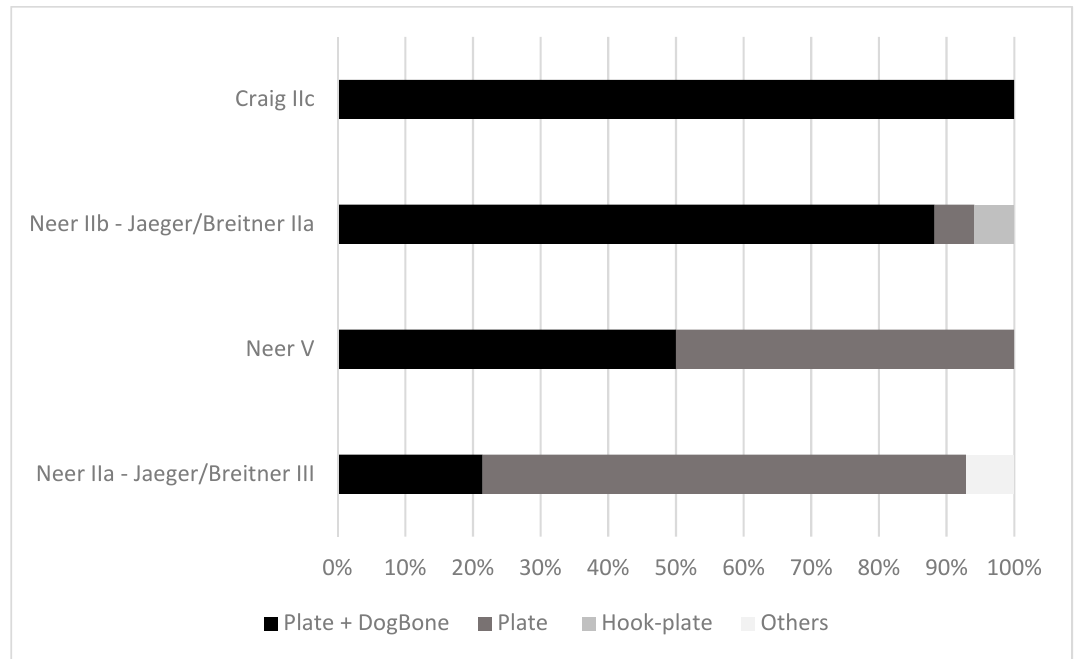
Scheme 1. Overview of the operative treatment strategy for unstable fracture types. The unstable fracture types are plotted on the Y-axis and the corresponding surgical fracture treatments on the x-axis. The black portion of the bars represents the patients who were operated on with locked plating and Dog Bone TM , the dark gray portion of the bars represents the number of patients who were operated on with locked plating only; the medium gray portion of the bars represents the patients who were treated with a hook plate; and the light gray portion summarizes all other types of treatment.